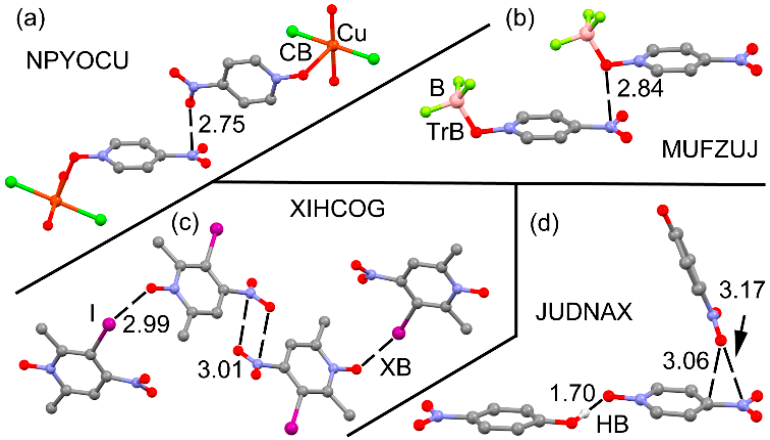
Figure 2. Partial views of the X-ray structures of NPYOCU ( a ), MUFZUJ ( b ), XIHCOG ( c ), and JUDNAX ( d ). Distances in